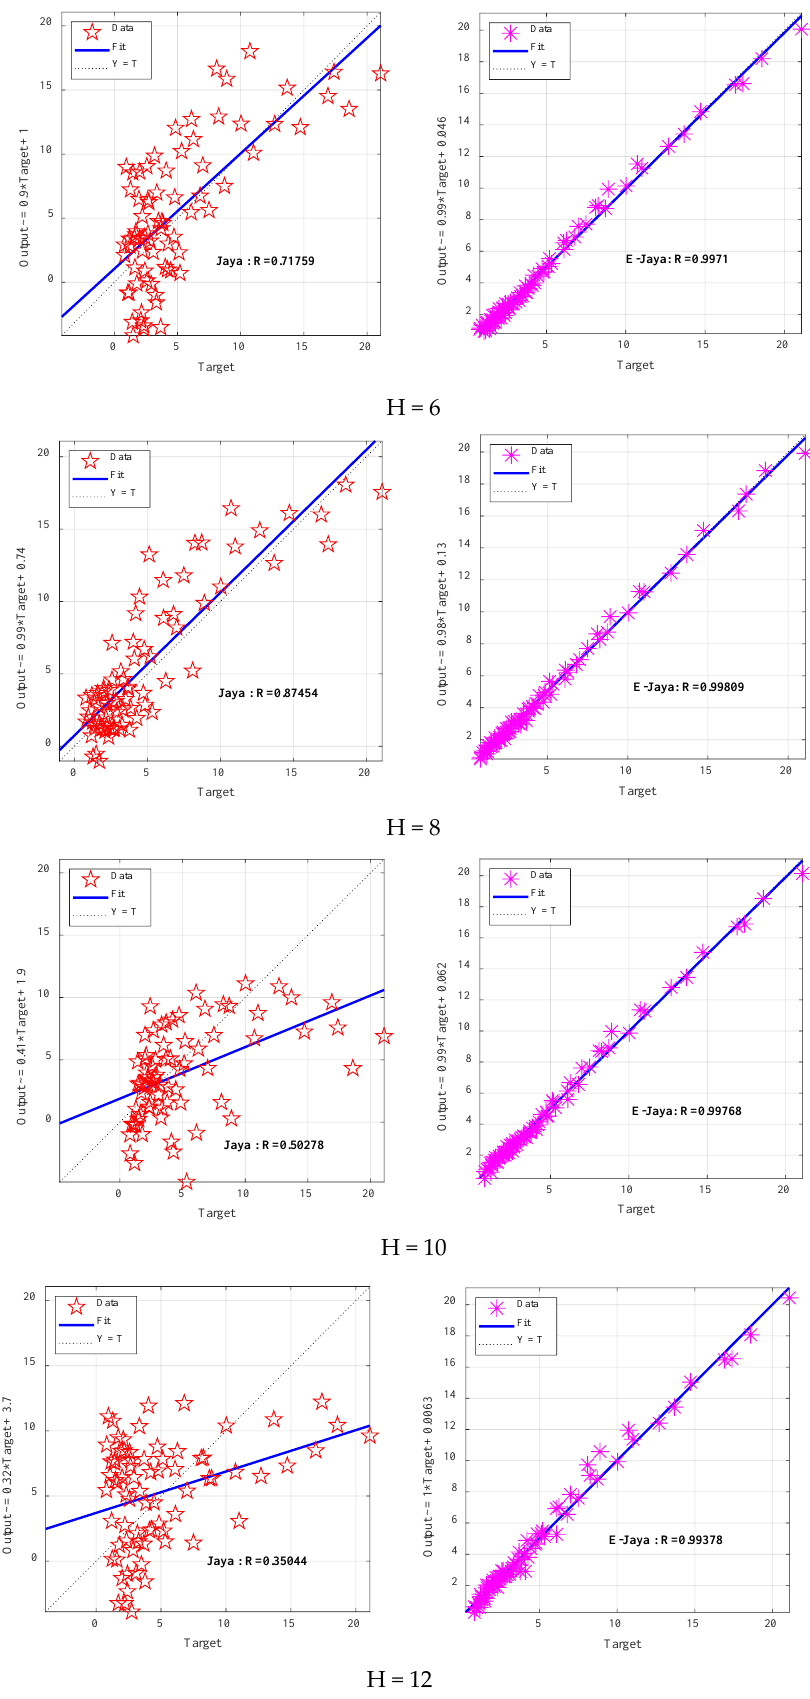
Figure 8. Regression analysis using Jaya and E-Jaya.